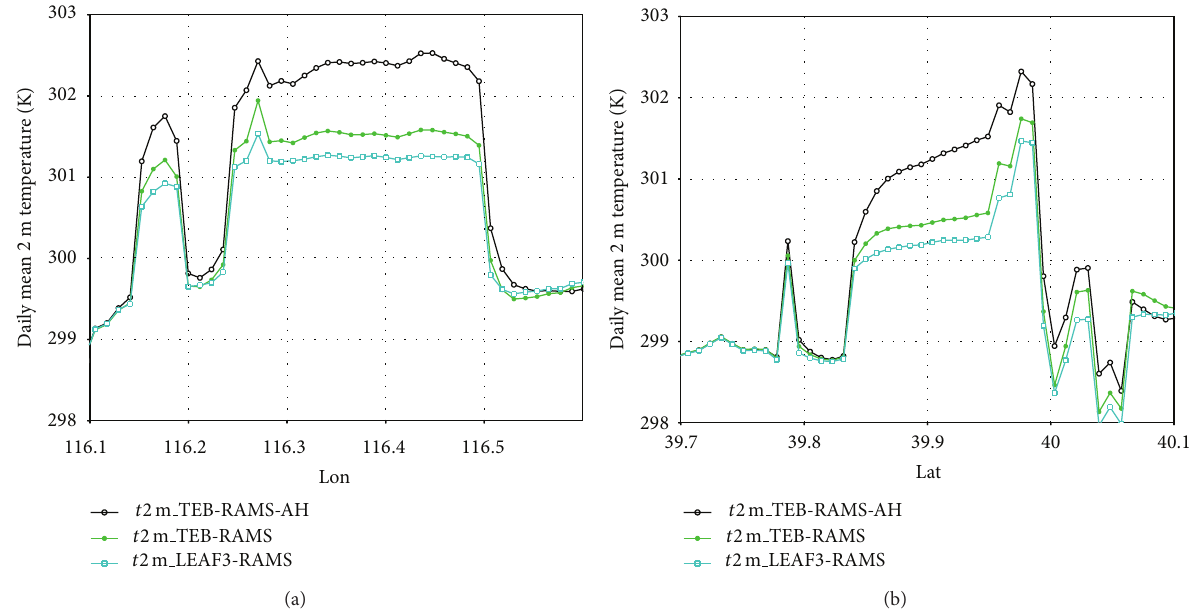
Figure 7: (a) Cross section of the daily mean air temperature at 2 m along line CD as shown in Figure 1(b) indicated by the black open circle line (TEB-RAMS-AH), green filled circle line (TEB-RAMS), and blue open square line (LEAF3-RAMS). (b) Same as in (a) but along the line AB also shown in Figure 1(b).